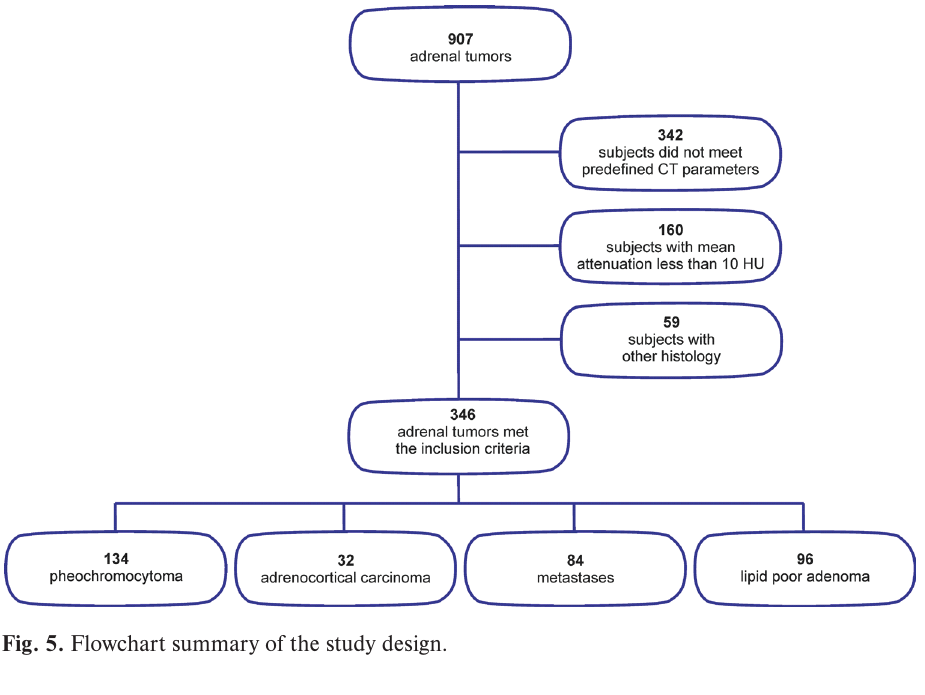
Fig. 5. Flowchart summary of the study design.